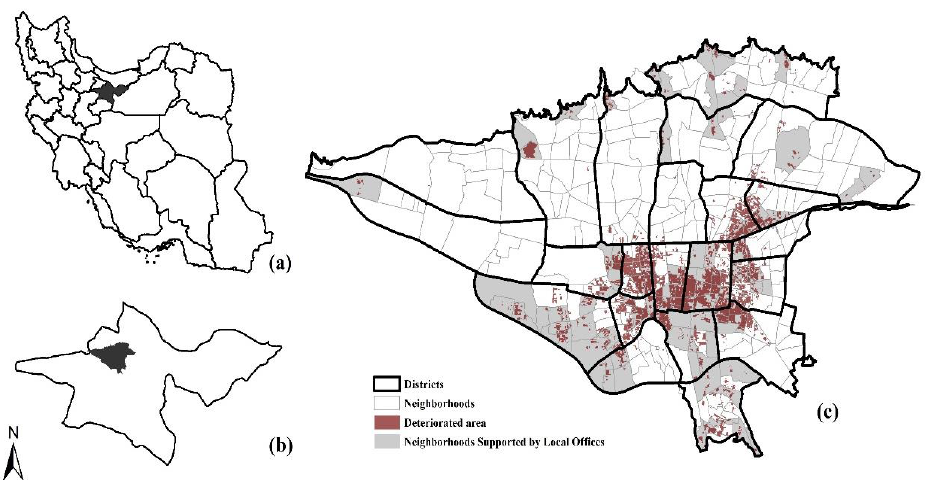
Figure 1. ( a ) Tehran Province in Iran; ( b ) Tehran City in Tehran Province; ( c ) distribution of deteriorated areas in Tehran and the neighborhoods supported by NDOs.